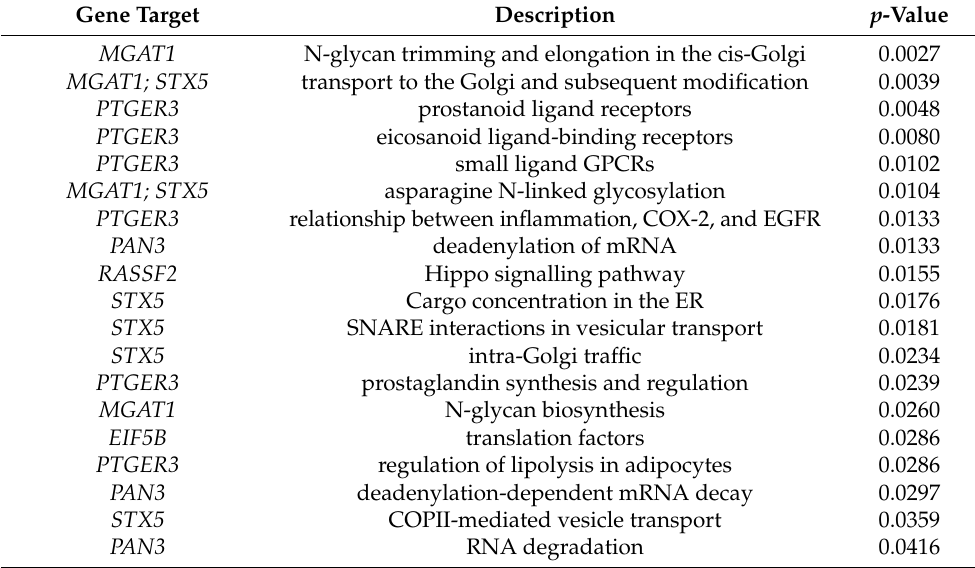
Table 5. Pathway analysis for the eight most significantly dysregulated